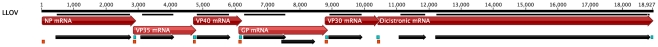
Genomic organization of LLOV.The black bars indicate the ORFs while the red arrows corresponding to their predicted mRNA transcripts. Start (turquoise) and termination (orange) signals for each transcript are displayed.